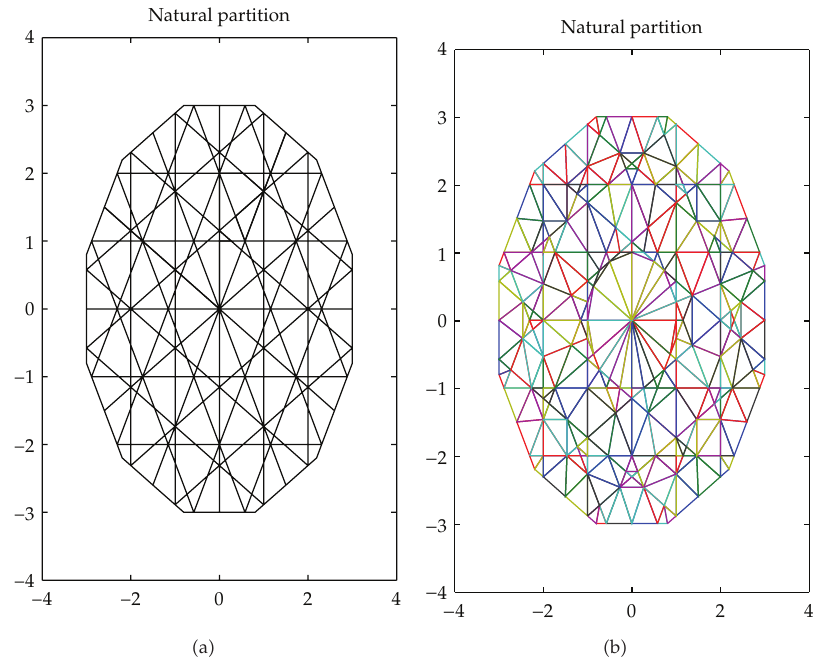
Figure 5: A comparison between the natural and the Delaunay